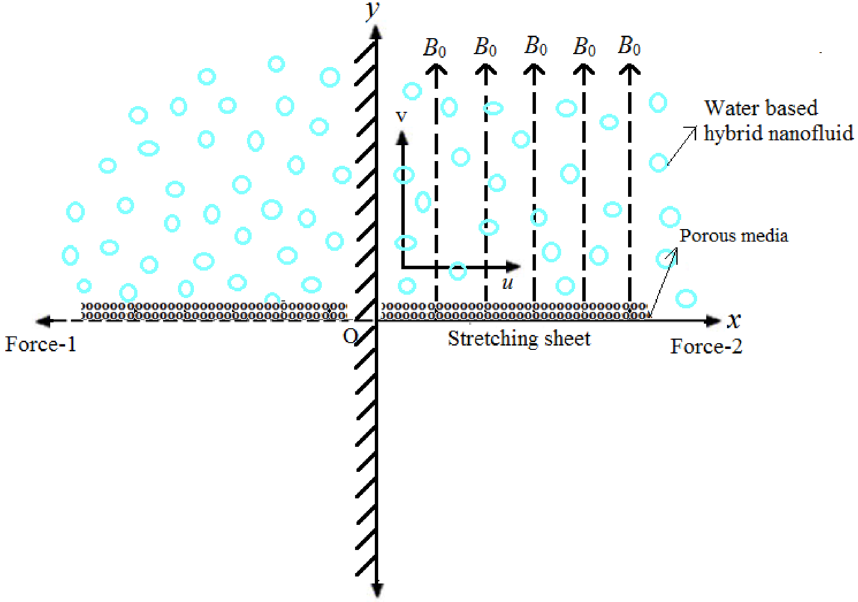
Figure 1. Schematic diagram representing the flow